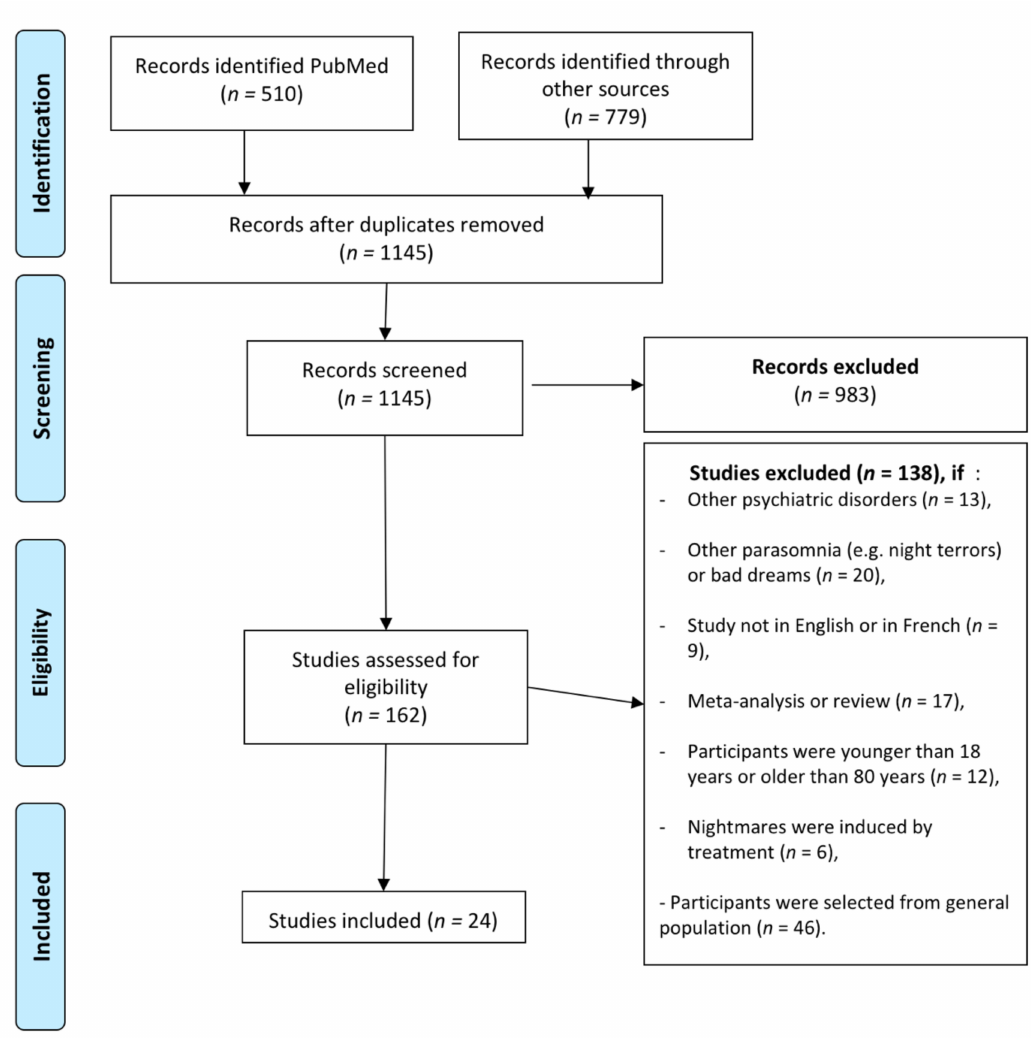
Figure 1. Flow diagram of nightmares and psychiatric disorders (mood and psychotic disorders) selection